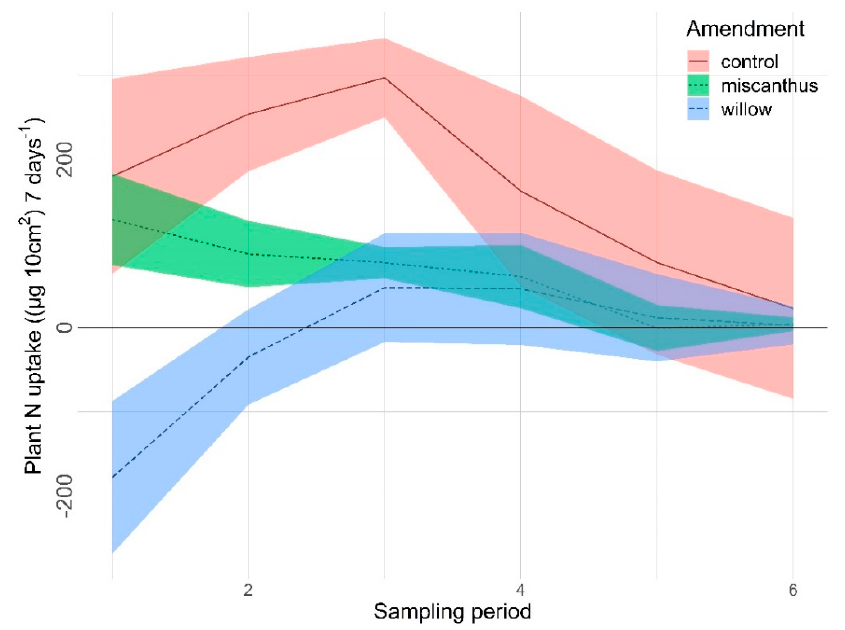
Figure 6. Plant N uptake index as a function of time and amendment. The colored area represents the error envelope as plotted with the geom_ribbon function in the ggplot2 R package.